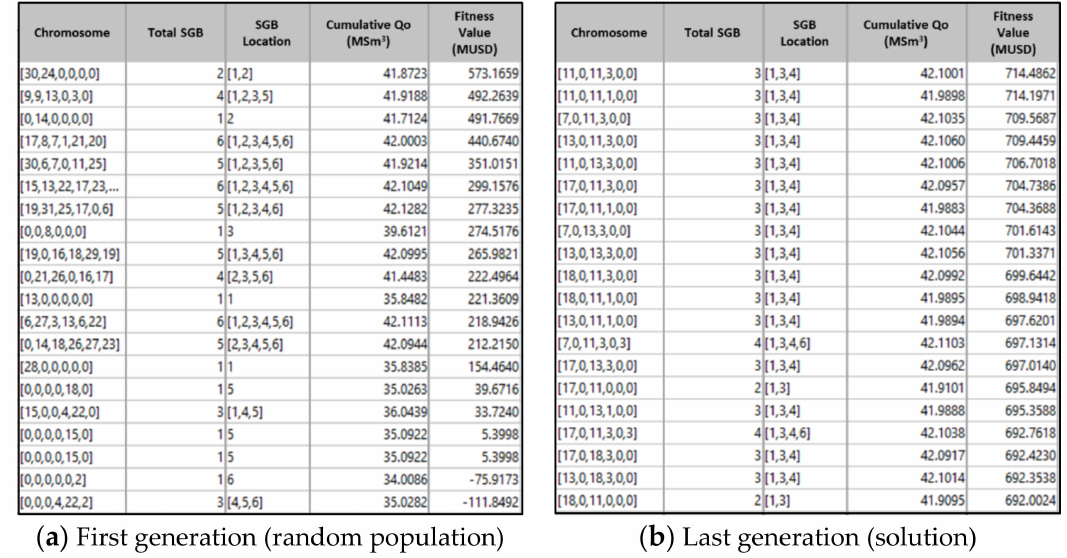
Figure 18. Comparison of the initial generation ( a ) vs. the last generation ( b